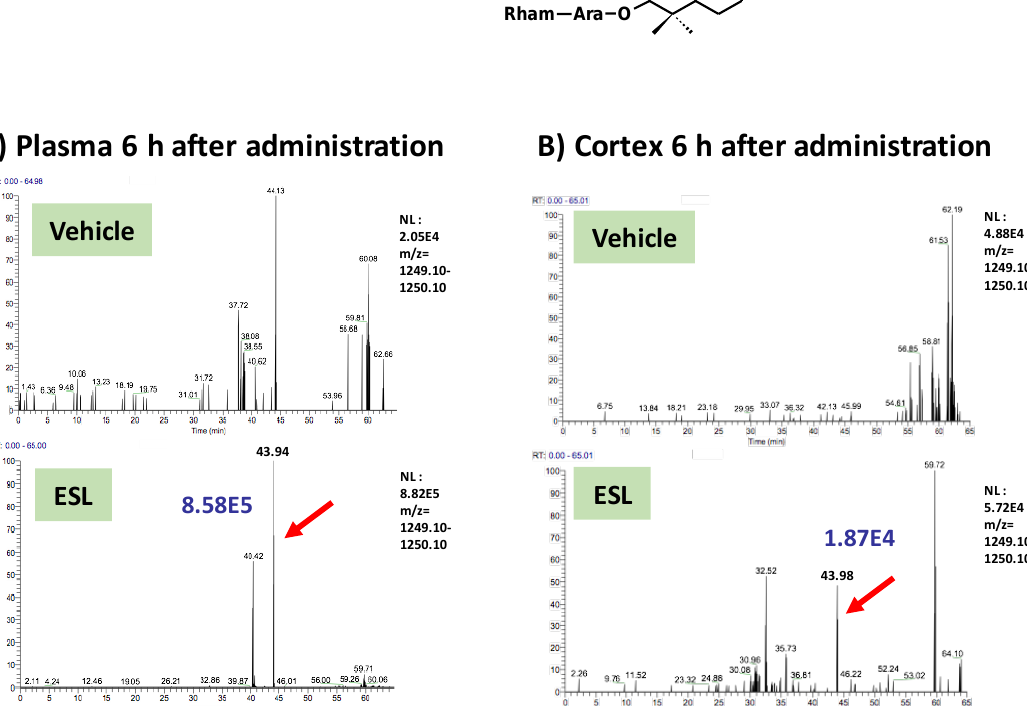
Figure 3. Eleutheroside M was detected in plasma and the cerebral cortex after oral administration of the leaf extract of E. senticosus. A structure of eleutheroside M and LC-MS charts of plasma ( A ) and cerebral cortex ( B ) from vehicle-treated and leaf extract-treated mice 6 h administration of the extract. Red arrows indicate a peak of eleutheroside M. A blue value means intensities of the peak.